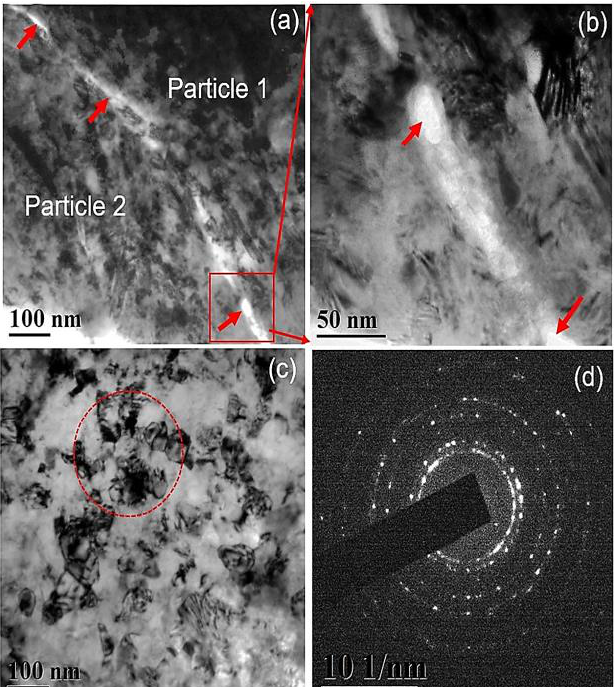
Figure 9. TEM images of the cross-section of a CS + MF IN 718 deposit: ( a – c ) nano-sized interparticle gaps and ( d ) supporting selected area electron diffraction (SAED) of the observed region. The red arrows indicate the presence of nano-sized inter-particle gaps, whereas the red circle indicates the refined crystals adjacent to the inter-particle boundaries. Reprinted from Lou et al. [80], Copyright 2018, with permission from